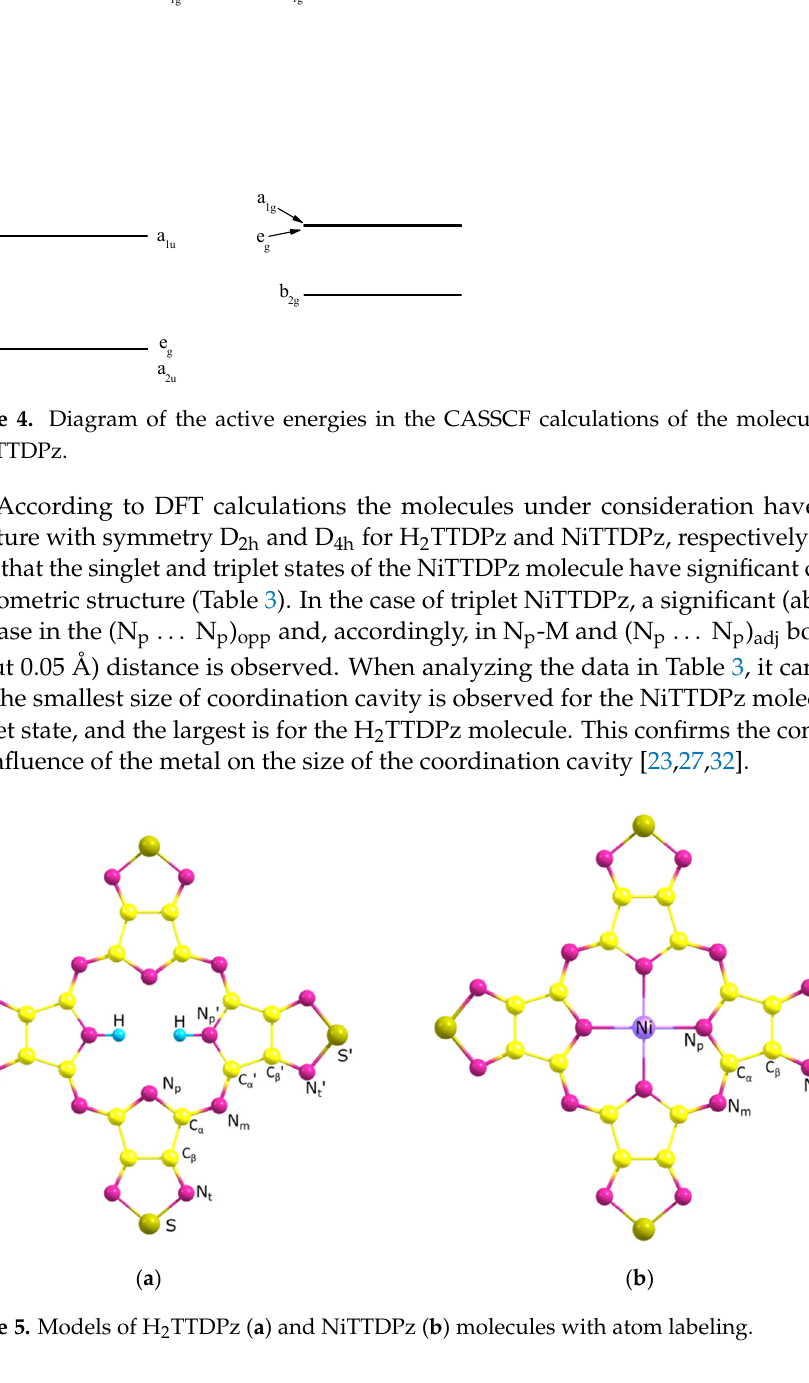
Figure 3. Shapes of active CASSCF molecular orbitals of NiTTDPz.